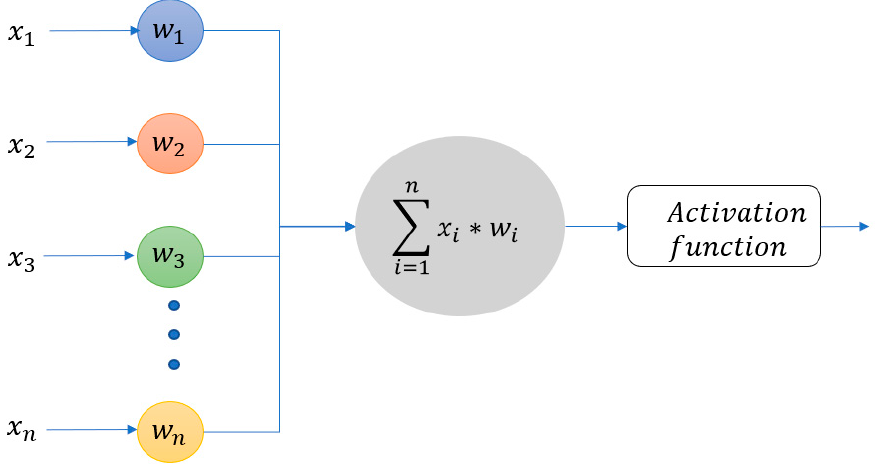
Figure 2. The figure shows how each neuron computes the output. The vector x = (x 1 , x 2 , x 3 , . . . , x n ) is the input, while the vector w = (w 1 , w 2 , w 3 , . . . , w n ) represents the weight for each